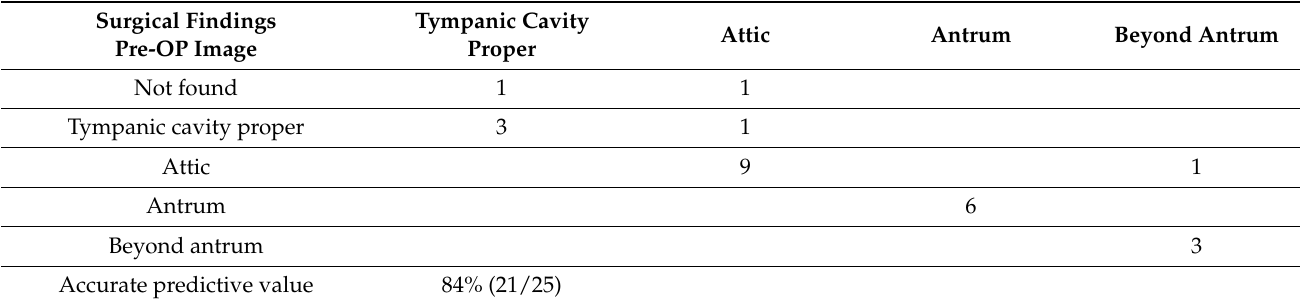
Table 3. The accuracy of preoperative DW-T1W-CT estimate on the extent of cholesteatoma. Surgical